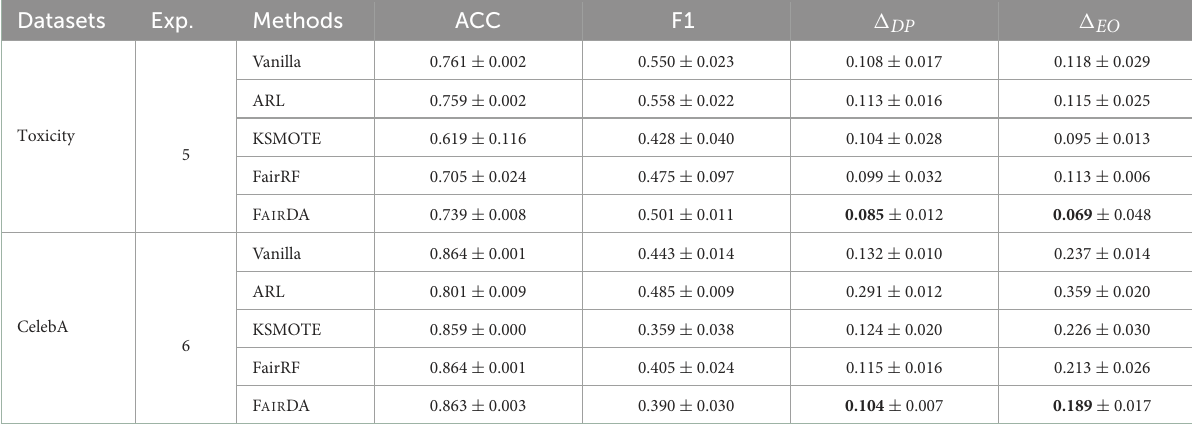
TABLE 4 Fairness performance comparison in the Toxicity and CelebA datasets.